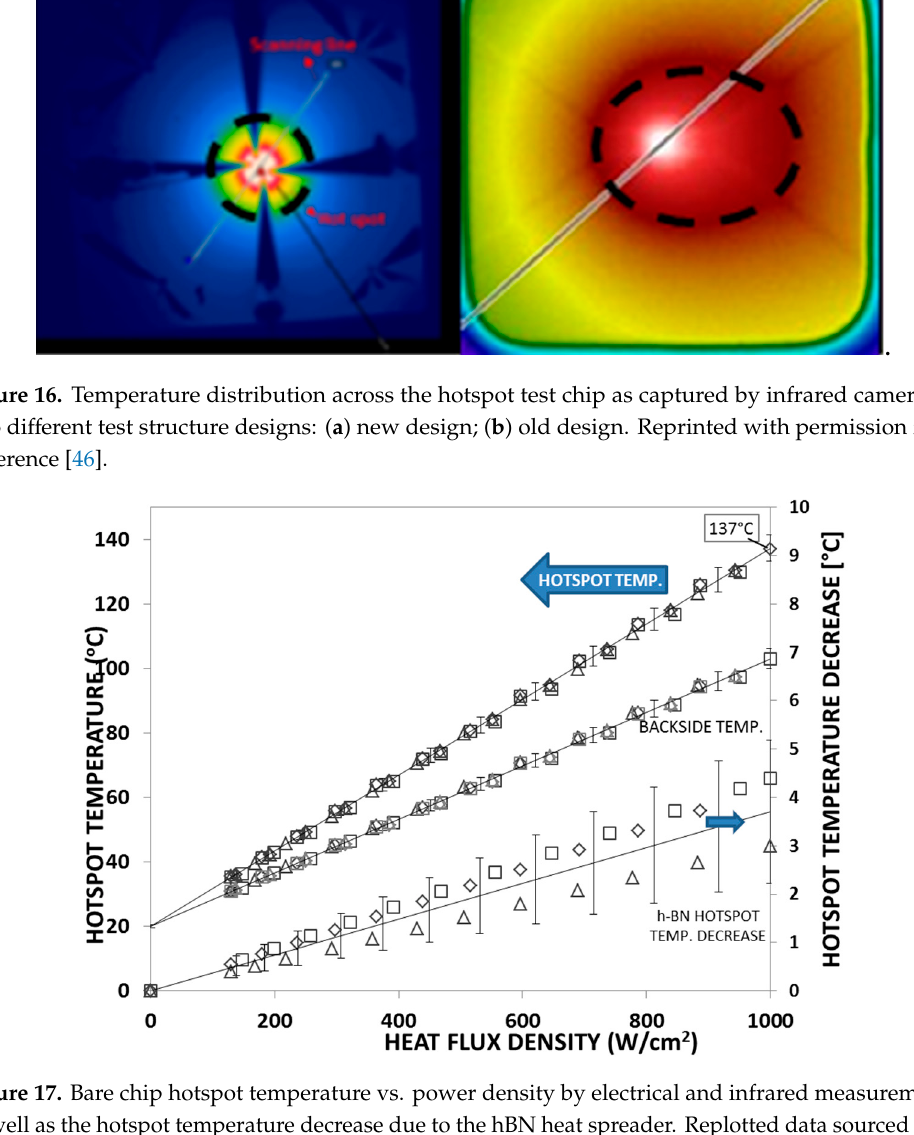
Figure 17. Bare chip hotspot temperature vs. power density by electrical and infrared measurements, as well as the hotspot temperature decrease due to the hBN heat spreader. Replotted data sourced from Reference [48].